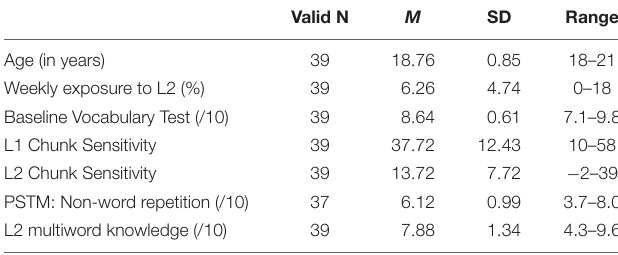
TABLE 2 | Summary of cognitive and proficiency